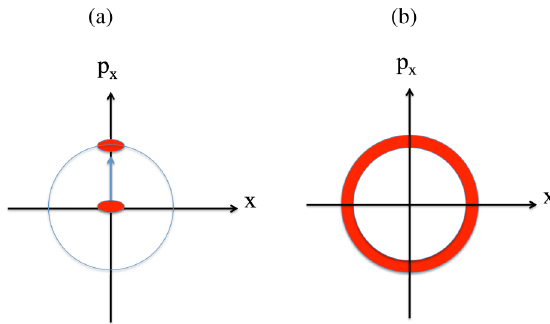
FIG. 4. In an arc with large product of the chromaticity and energy spread, a transverse-momentum kick received from linac (a) will not displace the bunch overall because the dependence of the phase-space rotation angle on the particles’ energy spreads their displacement evenly around the circle